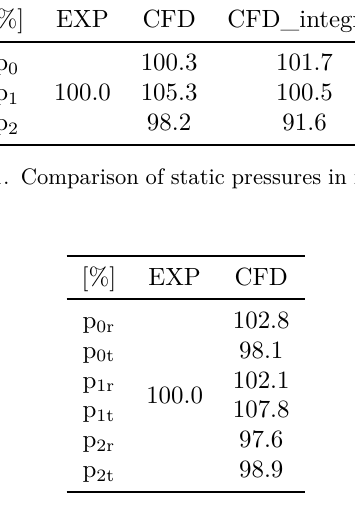
Table 2. Comparison of static pressures in local